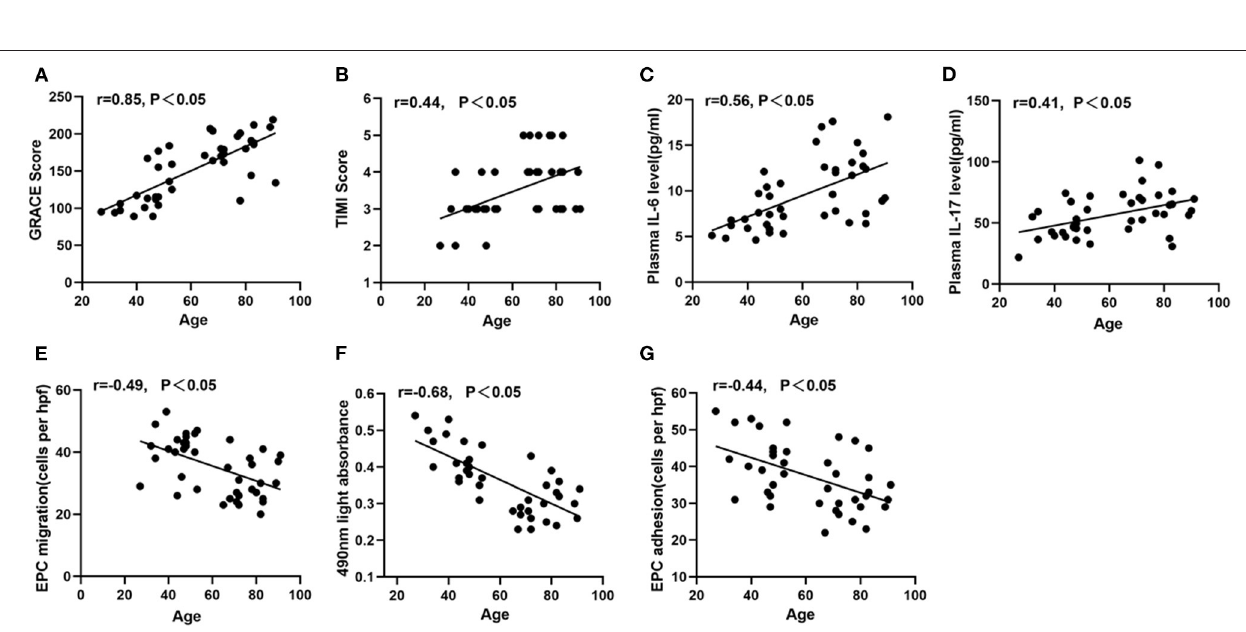
Frontiers in Cardiovascular Medicine |